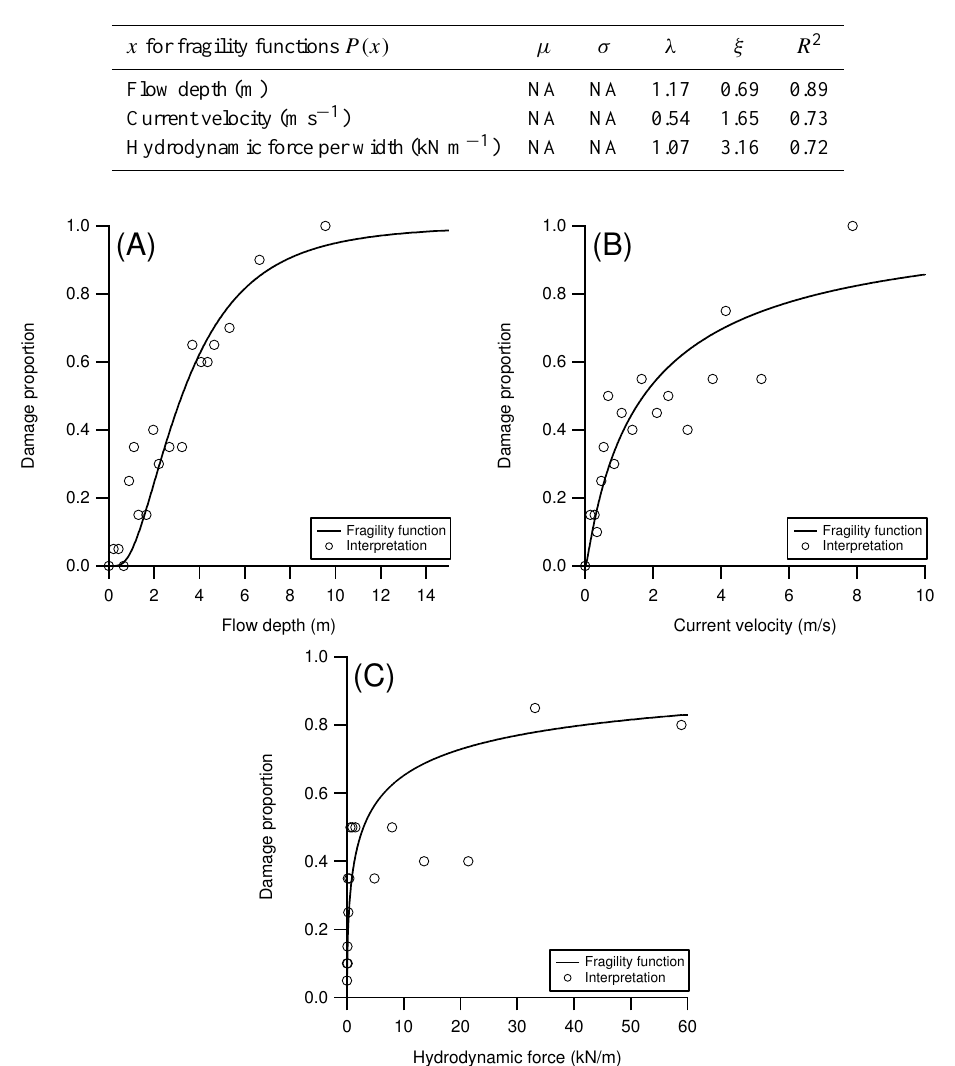
Table 4. Fragility-function parameters obtained from the regression analysis. R 2 is the coefficient of determination obtained by least-squares fitting.